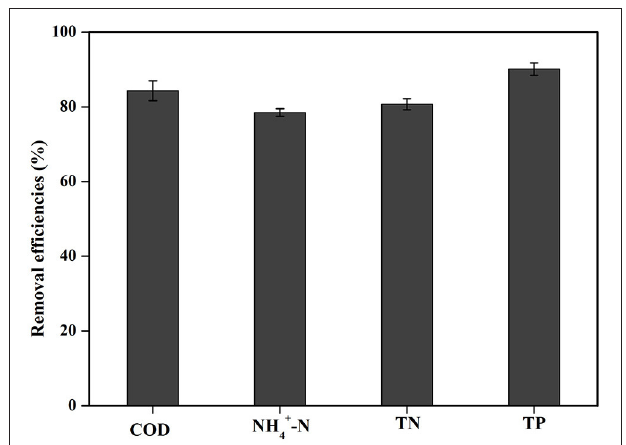
FIGURE 10 | Treatment of real domestic wastewater by Cu/ZnO/rGO (COD, NH + 4 -N, TN, and TP removal